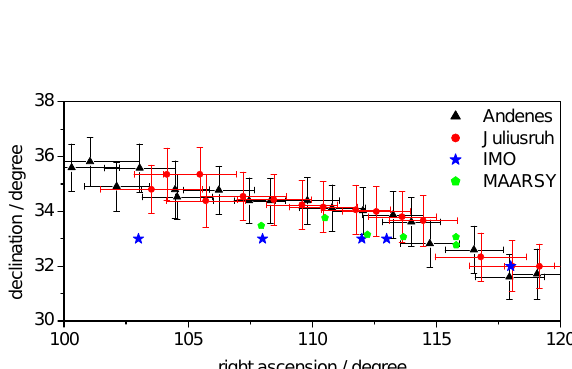
Fig. 3. Radiant position of the Geminid meteor shower for the An- denes and Juliusruh MR, IMO and MAARSY head echo observa- tions.